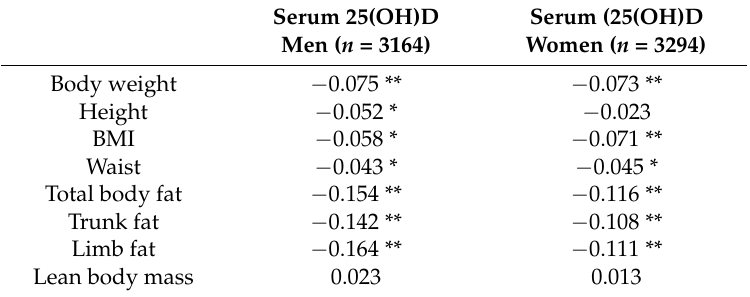
Table 2. Partial correlation of serum 25(OH)D with body weight, height, body fat, and lean body mass. Table 3. Comparison of variables by body weight tertile in both genders.